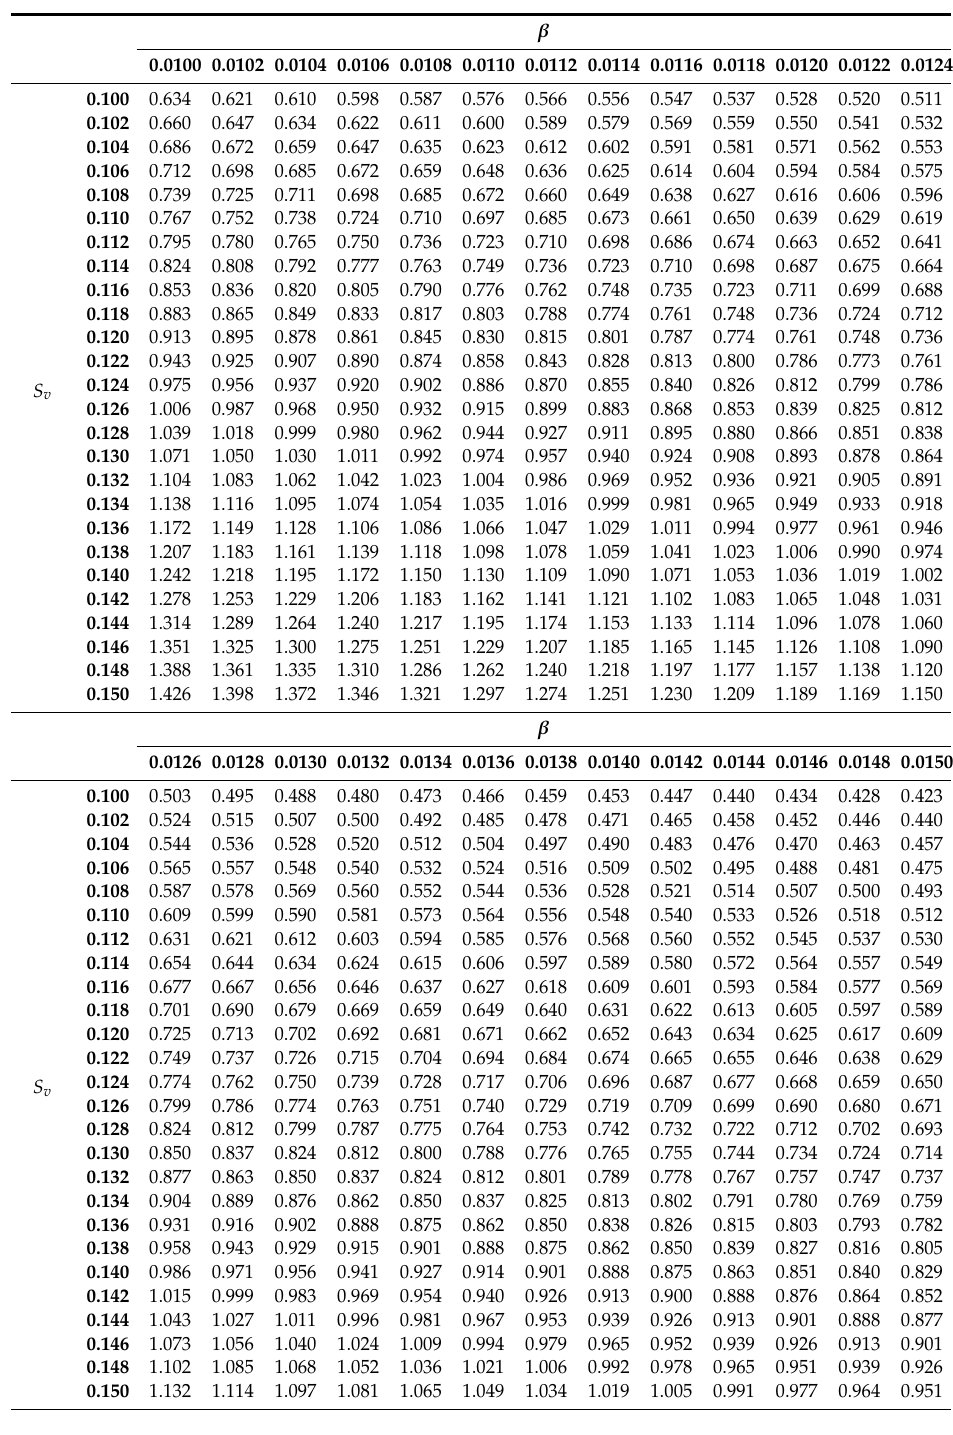
Table 1. Values of the UAE